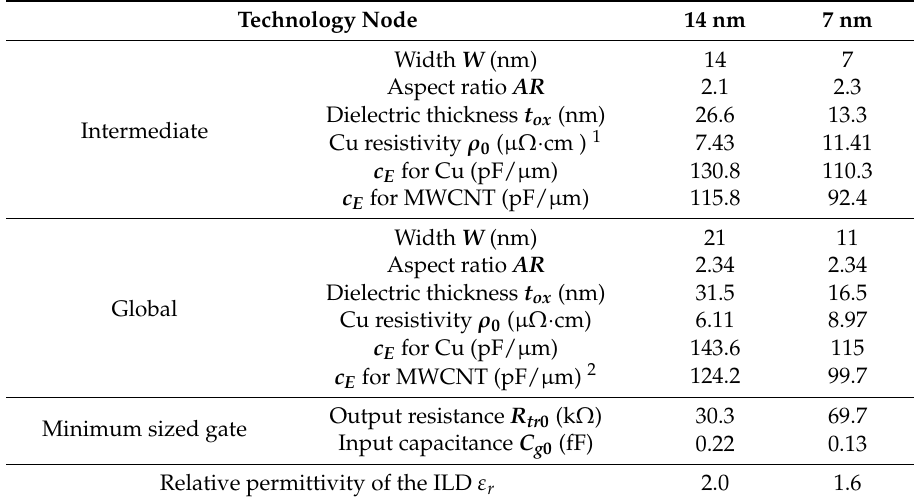
Table 1. Geometrical and physical parameters at the 14 nm and 7 nm technology